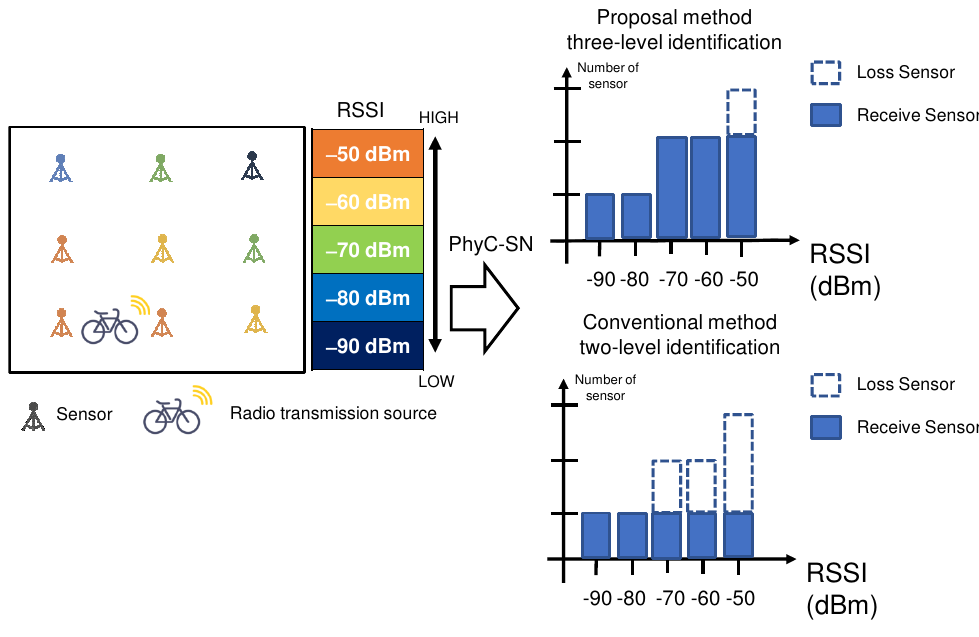
Figure 12. Comparison of missing sensor